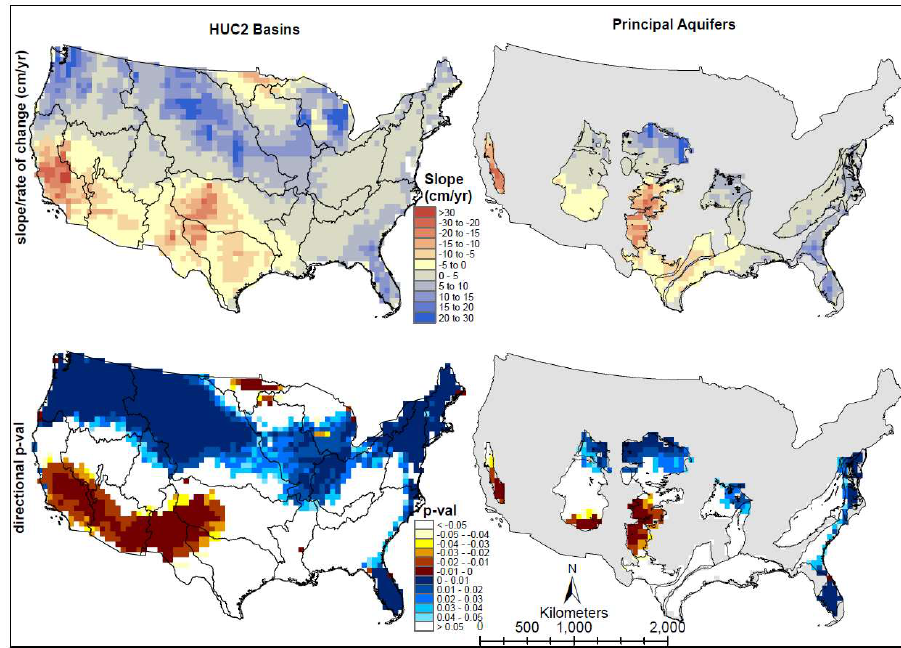
Figure 8. Spatially explicit rate of change (cm/year) and statistical significance of GRACE storage over CONUS (directional p-val). Top left : rate of change over HUC2 surface basins, Bottom left: areas of statistical significance over HUC2 surface basins. Top right: rate of change over principal aquifer systems. Bottom right: areas of statistical significance over aquifer systems.